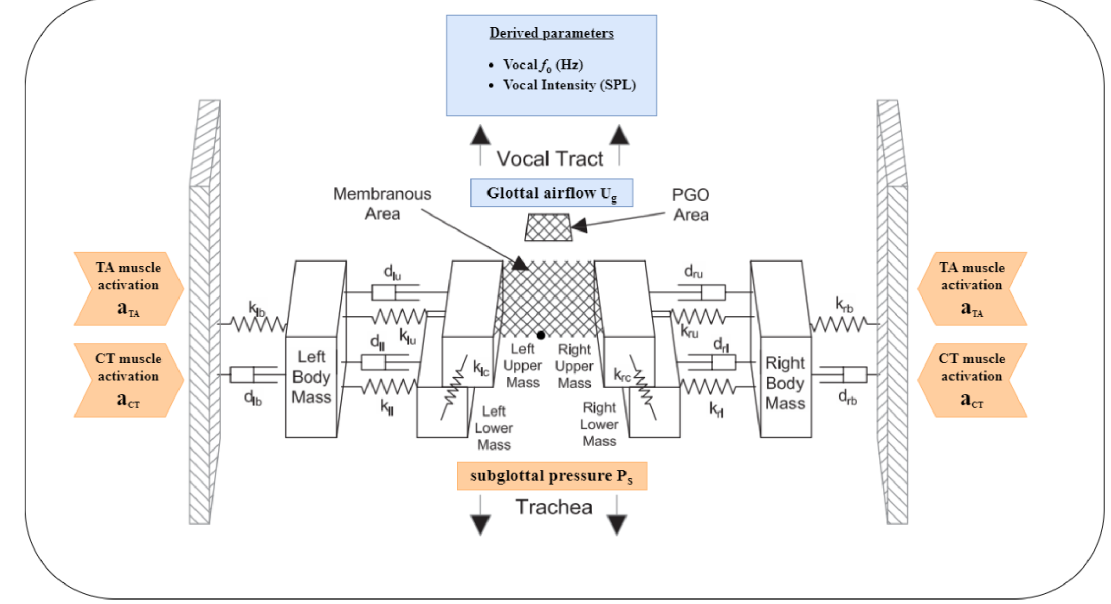
Fig 2. Extended Body-Cover Model. Vocal fold mobility variables input from or output to the DIVA model are shown in orange and blue shaded regions, respectively. Reproduced from Za ñ artu, Galindo [49] (https://doi.org/10.1121/1.4901714), with the permission of the Acoustical Society of